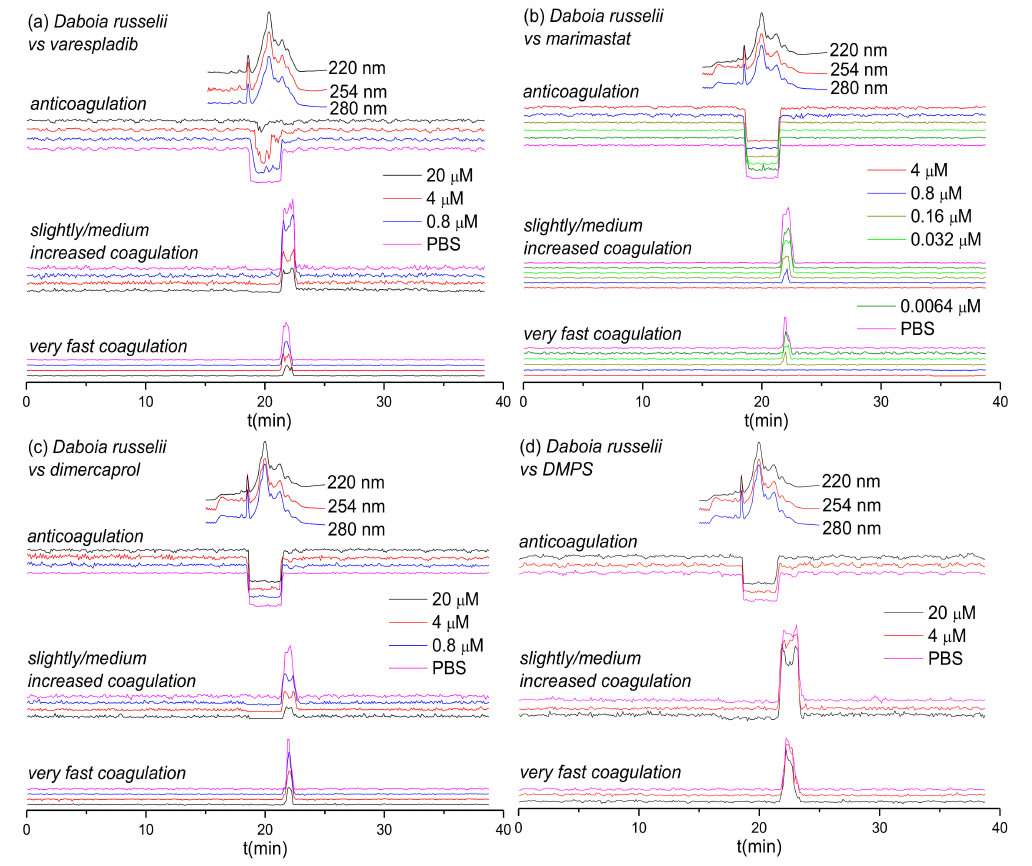
Figure 3. UV absorbance chromatograms and reconstructed coagulopathic toxicity chromatograms of nanofractionated toxins from D. russelii venom in the presence of di ff erent concentrations of ( a ) varespladib, ( b ) marimastat, ( c ) dimercaprol and ( d )